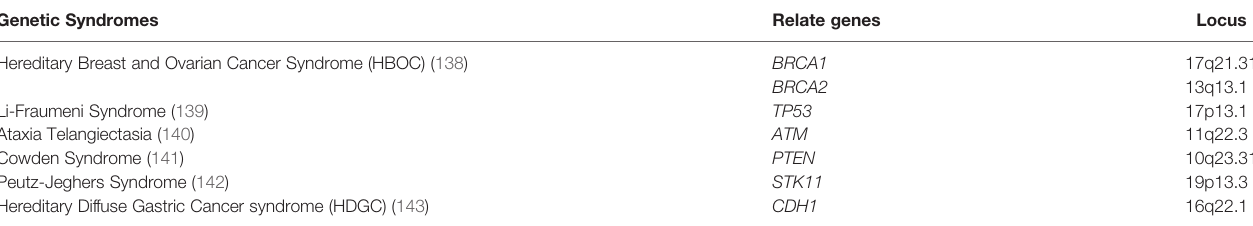
TABLE 3 | BC-related Genetic